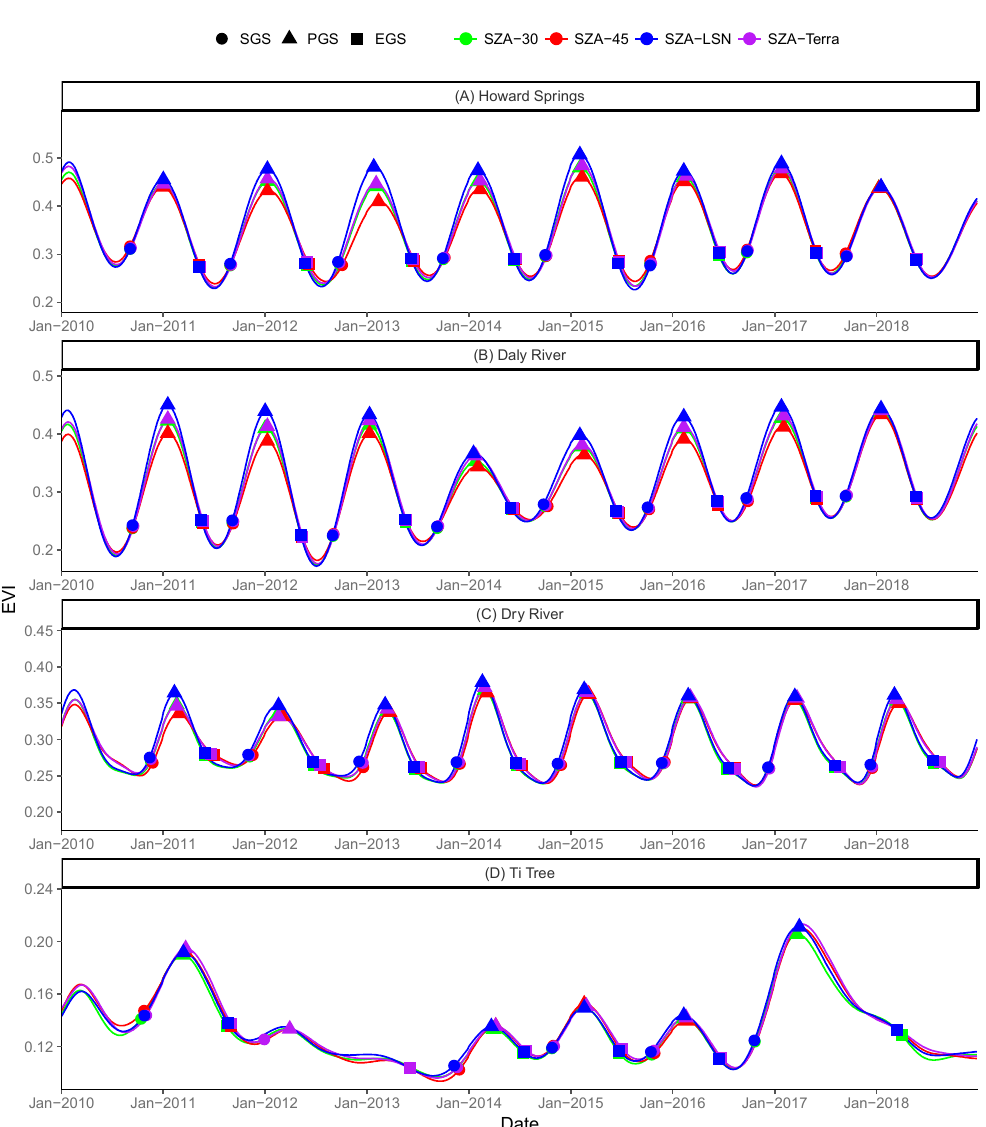
Figure 9. Time series of MODIS EVI at four NATT sites from 2010 to 2018. The light colour lines are original time series and the dark colour lines are gap-filled and reconstructed time series. Phenological transition dates are indicated on each line, including the start of greening season (SGS, solid circle), the peak of greening season (PGS, solid triangle), and the end of greening season (EGS, solid rectangle). Phenological metrics extracted from EVI with three different SZA configurations (all at nadir view), with SZA varying according to the Terra overpass time (SZA-Terra) and the local solar noon (SZA-LSN), or fixed at 30° (SZA-30) or 45° (SZA-45).